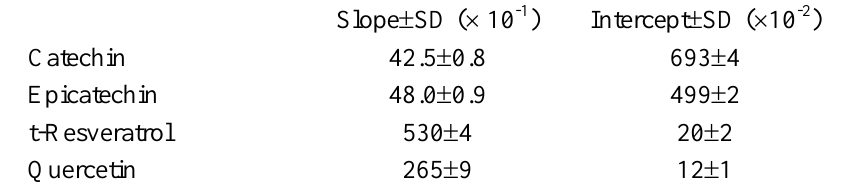
Table 1. Typical calibration data (peak area, arbitrary units vs C, mg Kg -1 ) for the standard addition method for a red grape sample *